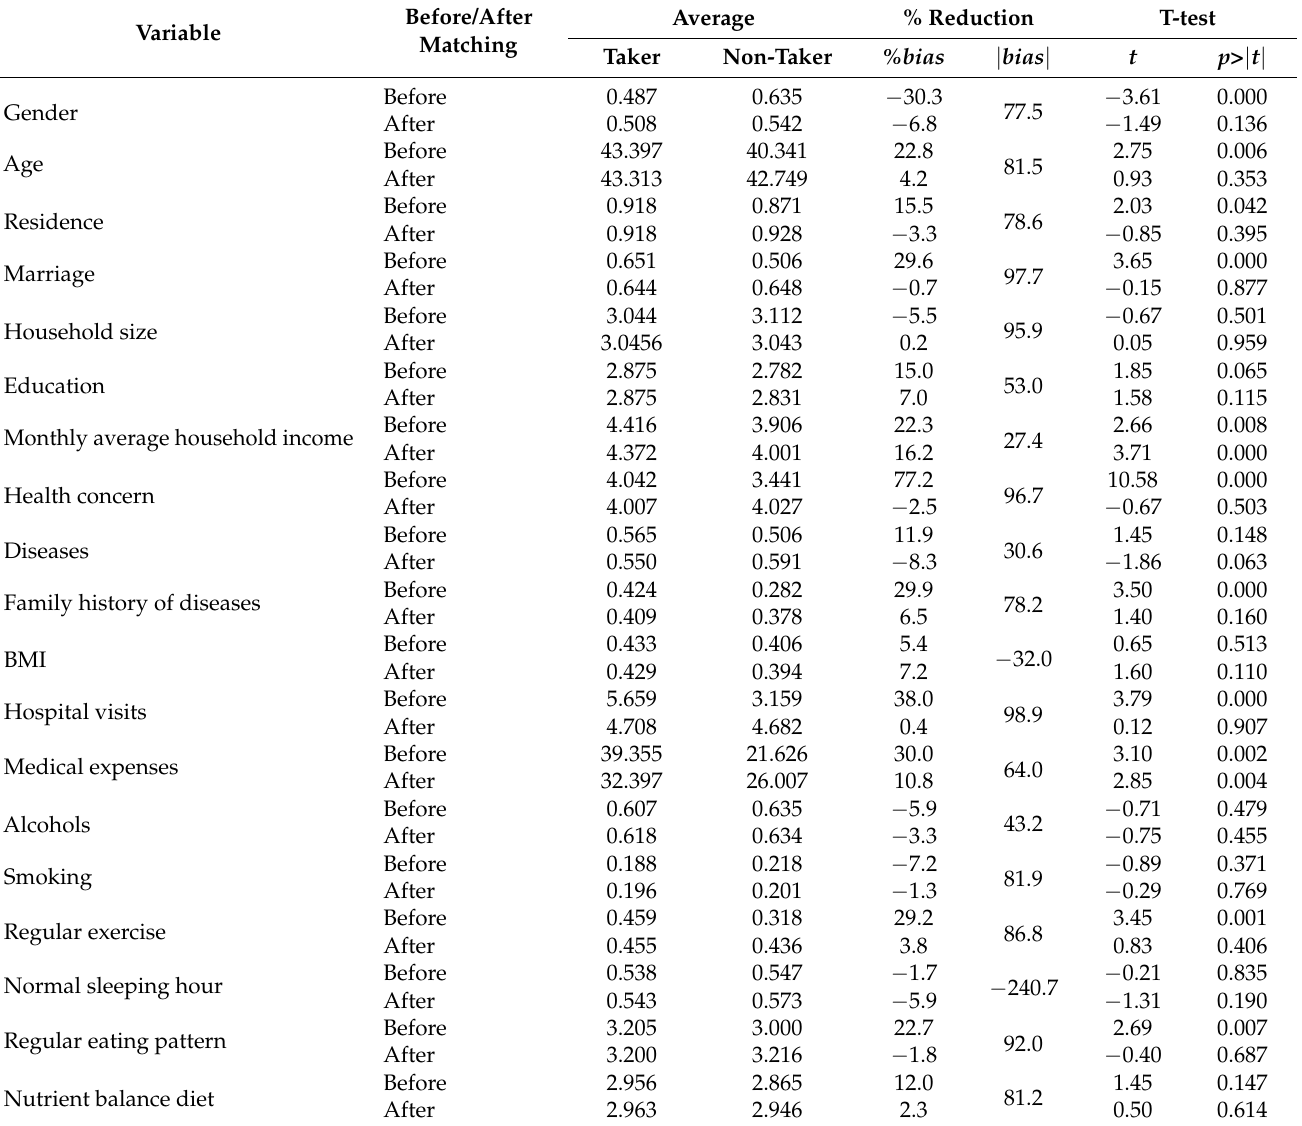
Table A2. Balance test results for covariates before and after matching (kernel